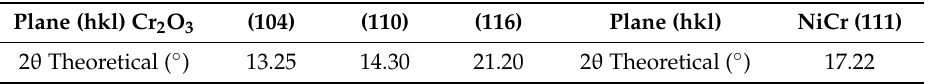
Table 3. Reference positions for the free of stress diffraction peaks that are used in [15].